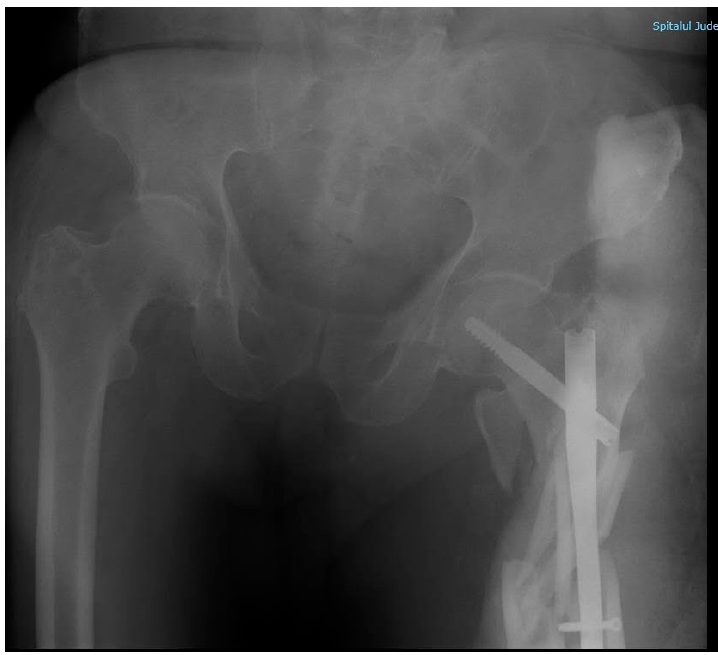
Figure 7. Hip X-ray after 3-m height fall, anteroposterior incidence. Description: male subject. Right hip with minimally narrowed joint space. Left hip in the ⅓ proximal of the femur with osteosynthesis material (femoral rod distally nailed) slightly moved, degraded. Comminuted fracture with bone fragments misaligned in the proximal diaphysis of the left femur, with angulation of fragments. Loss of contour between normally continuous line from medial edge of femoral neck and inferior edge of the superior pubic ramus. Minimally impacted left femoral neck.